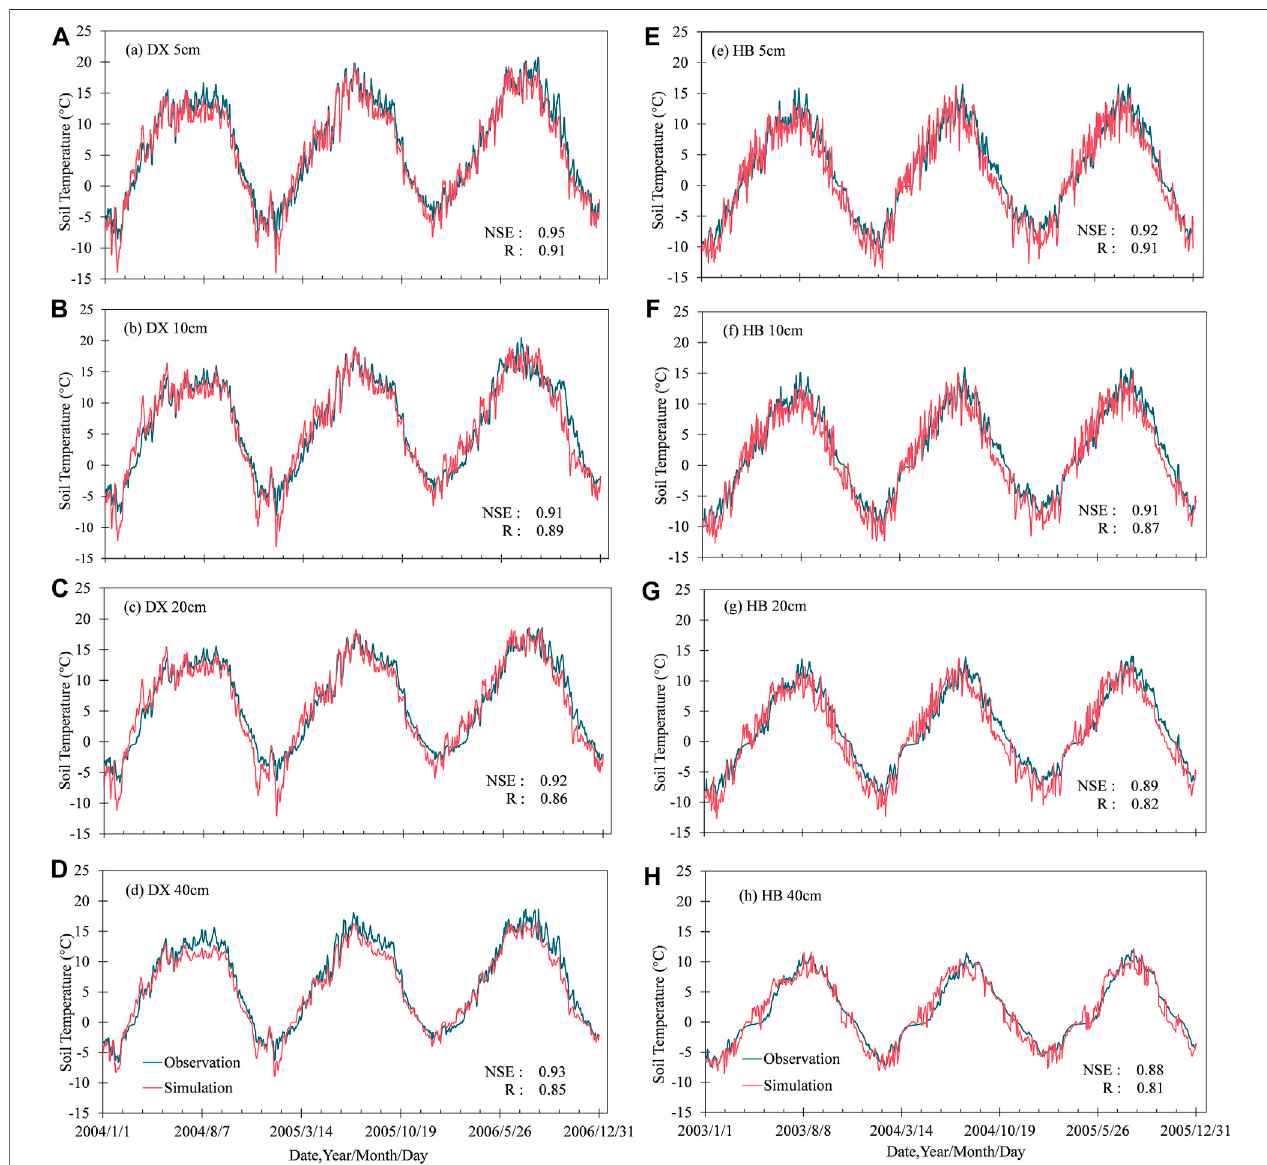
FIGURE 2 | Simulated and observed soil temperatures at different depths at Damxung [DX, (A – D) ] and Haibei [HB, (E – H) ] sites. NSE: Nash-Sutcliffe ef fi ciency coef fi cient; R: Pearson ’ s correlation coef fi cient.